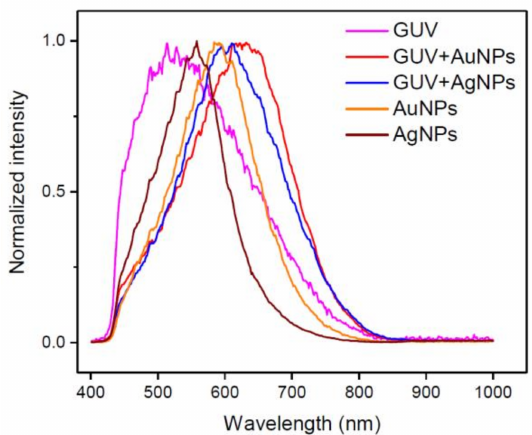
Figure 4. The normalized spectral profiles averaged from the highlighted regions in previous figures for AuNPs, AgNPs, GUVs, GUV+AuNPs, and GUV+AgNPs, respectively. The GUVs shown in this graph were made of 20 mol%